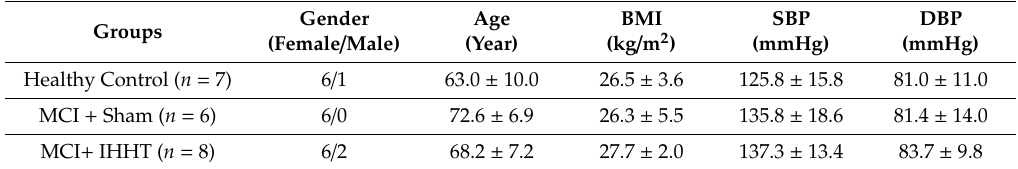
Table 5. Anthropometric characteristics of the